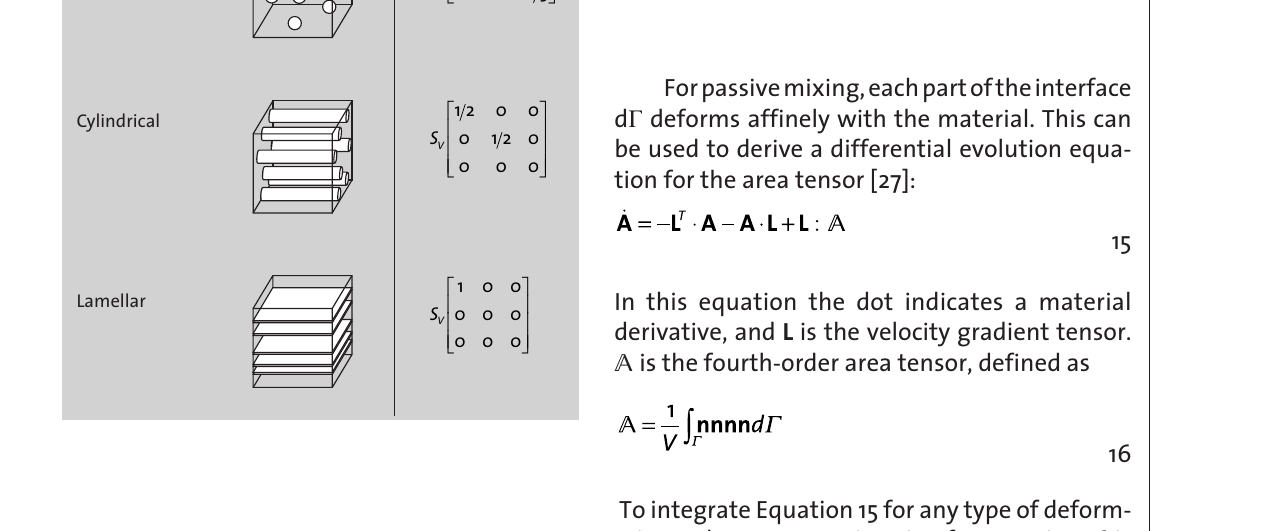
Table 1: Three microstructures and their corresponding area